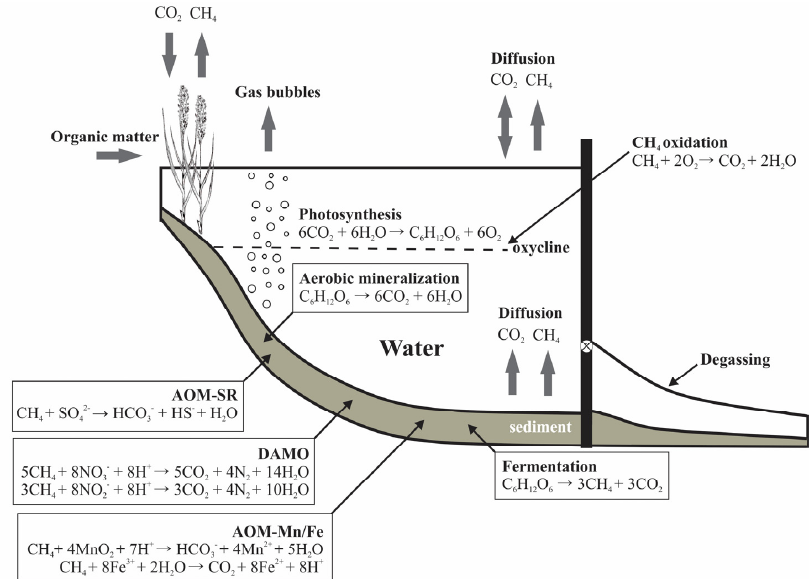
Figure 1. Transformations of CH 4 and CO 2 ongoing in reservoirs, plus transfer to the atmosphere; AOM-SR—anaerobic oxidation of methane coupled to sulfate reduction, DAMO—anaerobic oxidation of methane coupled to nitrate and nitrite reduction and AOM-Mn/Fe—anaerobic oxidation of methane coupled to manganese and iron reduction.